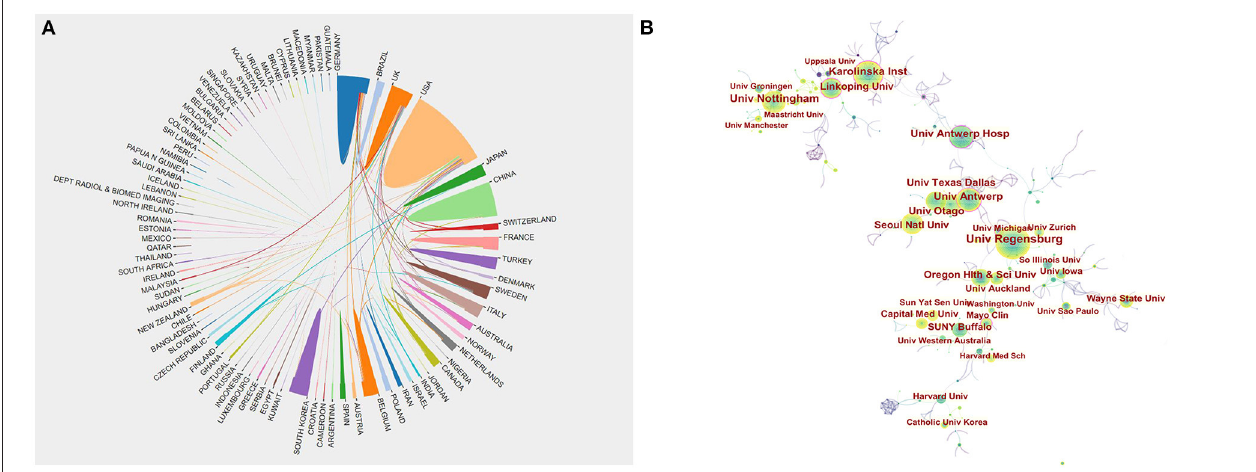
FIGURE 3 | The co-operation of countries/regions (A) and institutions (B) contributed to publications on tinnitus research from 2001 to 2020. The color and thickness in the inner circle of the node indicated the occurrence frequency of different time periods.